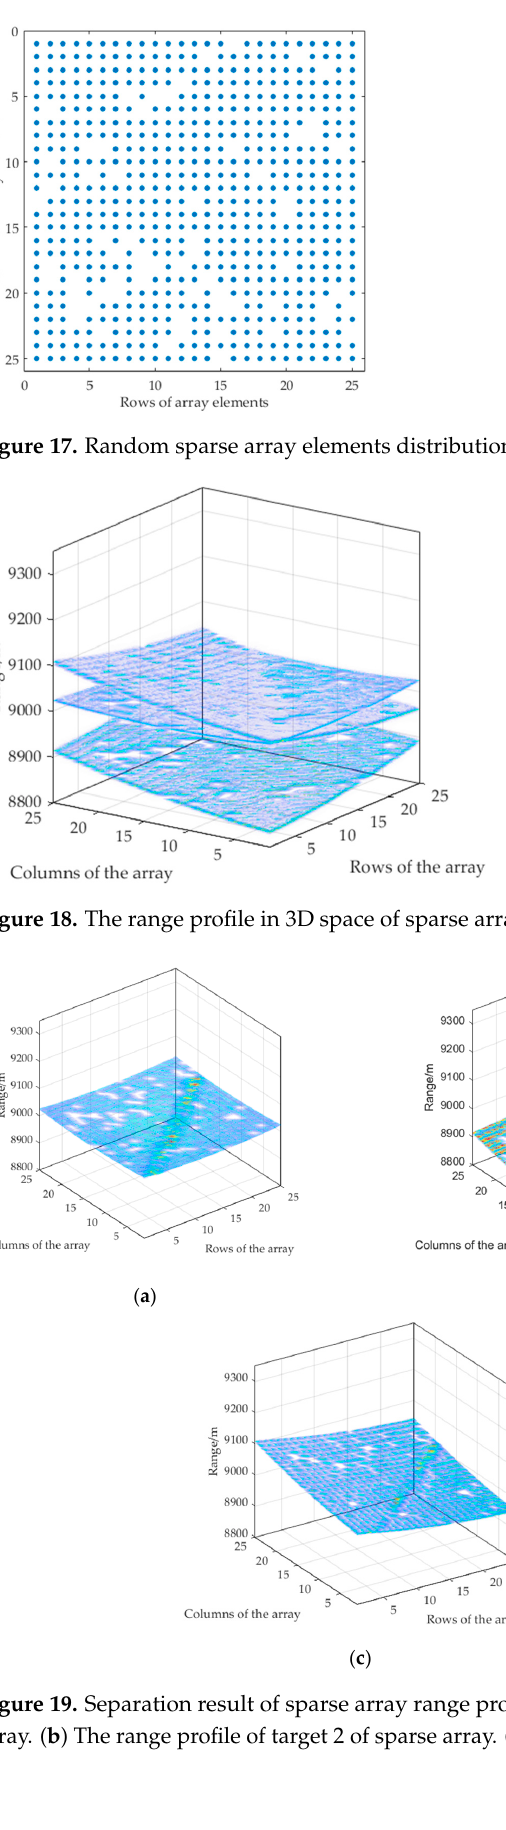
( b ) Figure 20. Sparse array 3D imaging results with two sparse imaging algorithms. ( a ) Sparse array imaging result with basis pursuit algorithm. ( b ) Sparse array imaging result with OMP algorithm.